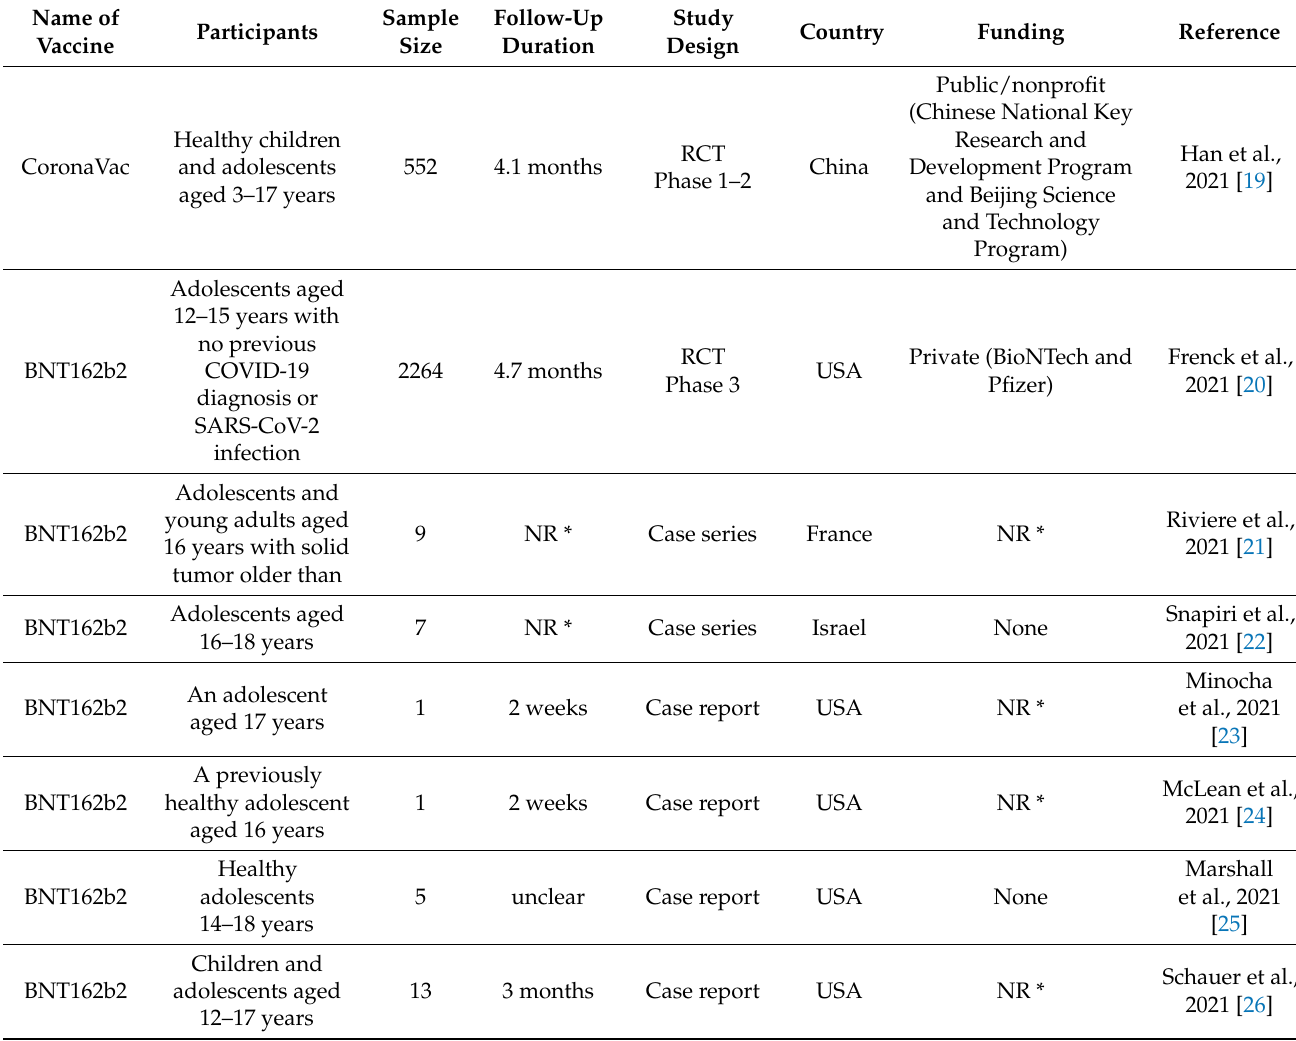
Table 1. Basic characteristics of included clinical studies (n =